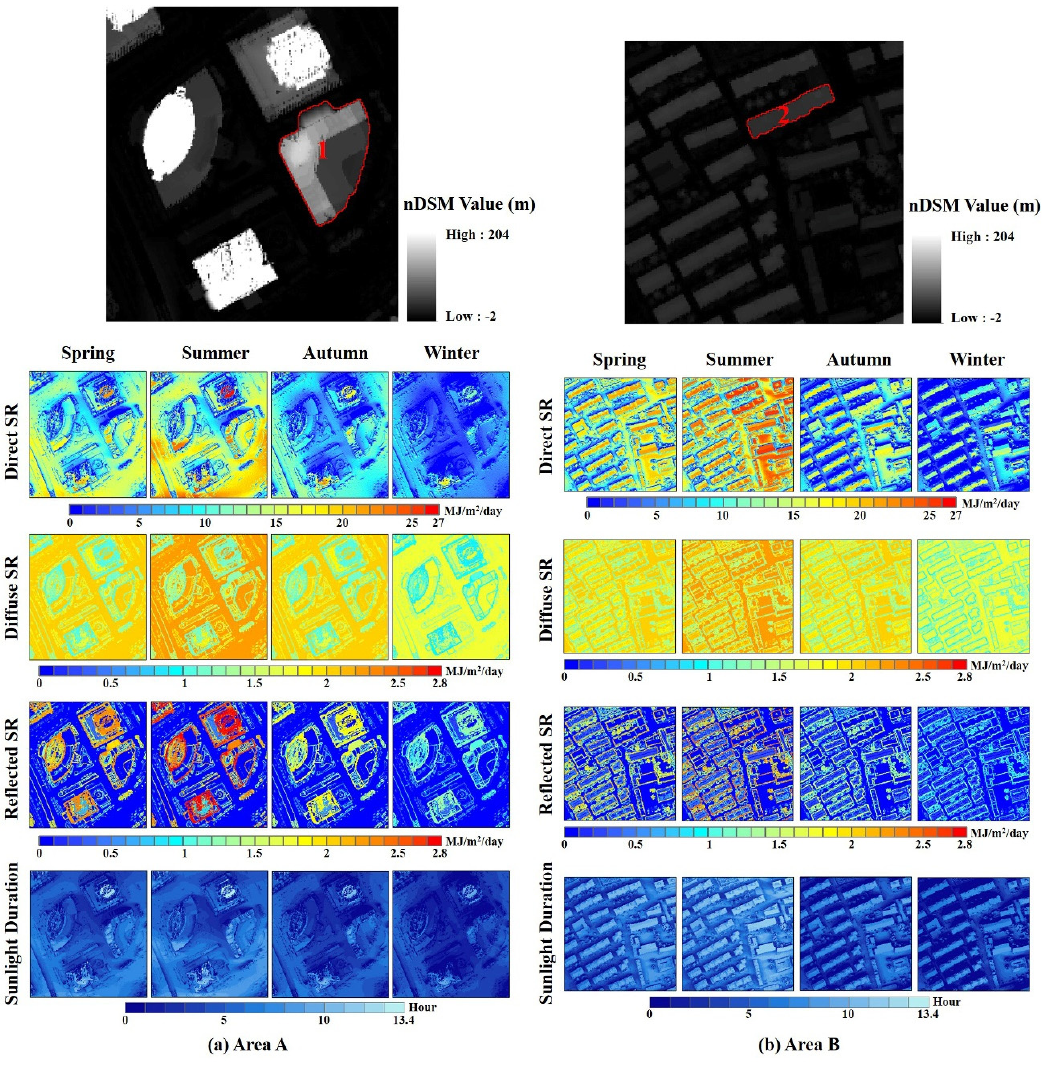
Figure 7. The direct, diffuse, reflected solar radiation and sunlight duration for four seasons in two sample areas: Area A (31°14 ′ 21 ′′ N-31°14 ′ 28 ′′ N, 121°30 ′ 10 ′′ E-121°30 ′ 18 ′′ E) and Area B (31°14 ′ 15 ′′ N- in two sample areas: Area A (31 ˝ 14 1 21 11 N-31 ˝ 14 1 28 11 N, 121 ˝ 30 1 10 11 E-121 ˝ 30 1 18 11 E) and Area B